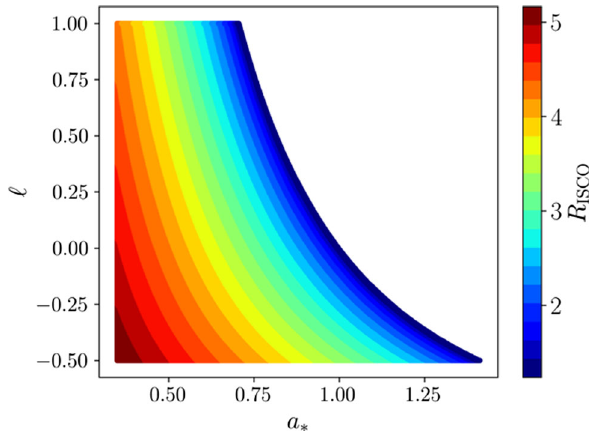
Fig. 1 ContourlevelsforthevalueoftheISCOradius R ISCO inBoyer– Lindquist coordinates on the plane a ∗ vs. (cid:2) . The white region is ignored